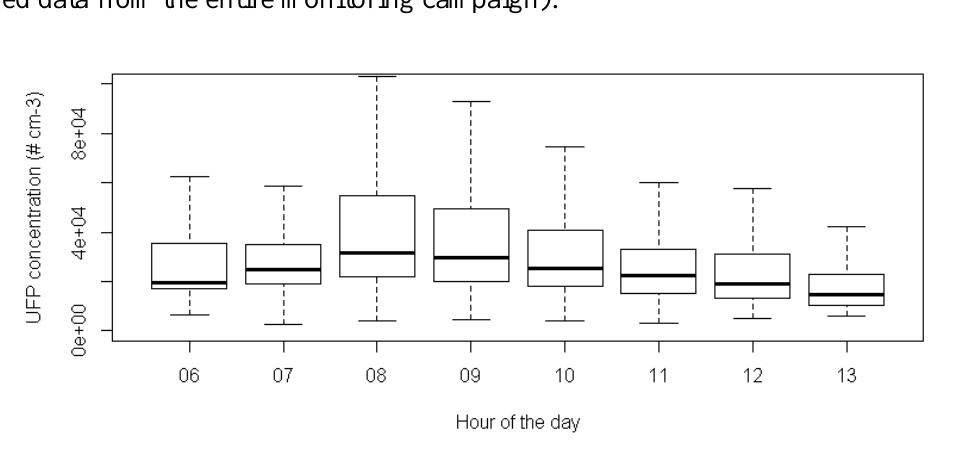
Figure 8. Boxplot of the UFP and BC concentrations in function of hour of the day (merged data from the entire monitoring